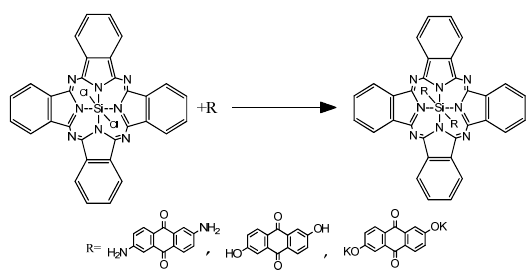
Figure 1. General reaction to obtain SiPcL 2 derivatives. SiPc: silicon